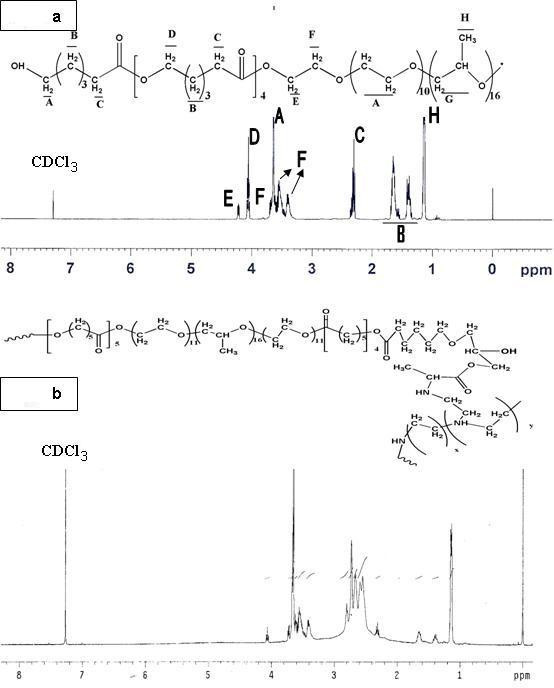
1H-NMR spectrum (400 MHz) of PCL-Pluronic-PCL copolymer and PCFC-g-PEI in CDCl3.